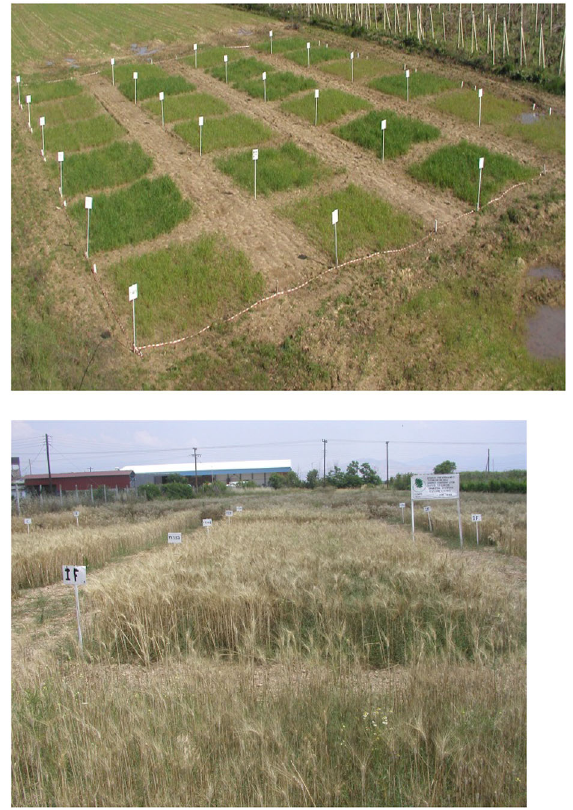
Fig. 1 Experiment in Platanoulia area, central Greece of concurrent application of CFA and MSS with wheat in different growth